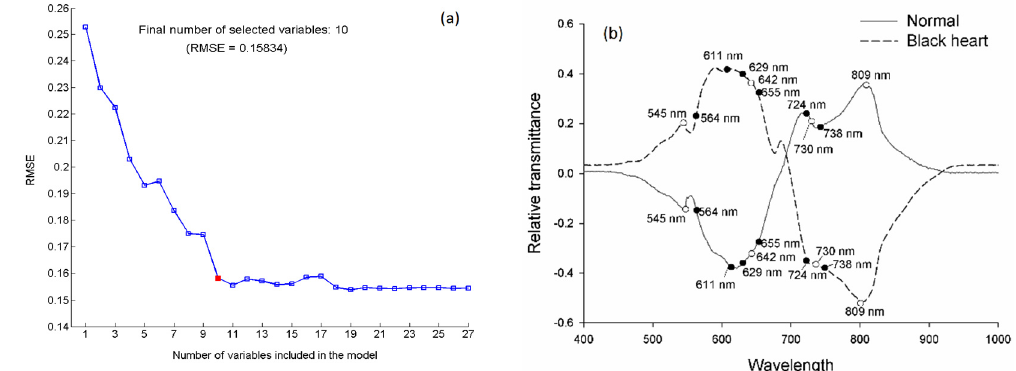
Figure 4. The RMSE (root mean square error) plot ( a ) and selected wavelengths (designated by open and solid circle markers); ( b ) by SPA (successive projections algorithm) with spectral preprocessing using SNV+ MC (mean center).